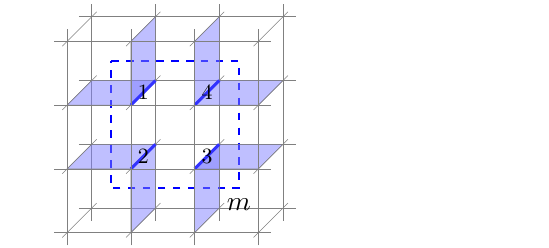
Figure 15. The fusion of two 1 c -strings is 1 c ⊗ 1 c = 1 c ⊕ 1 c .